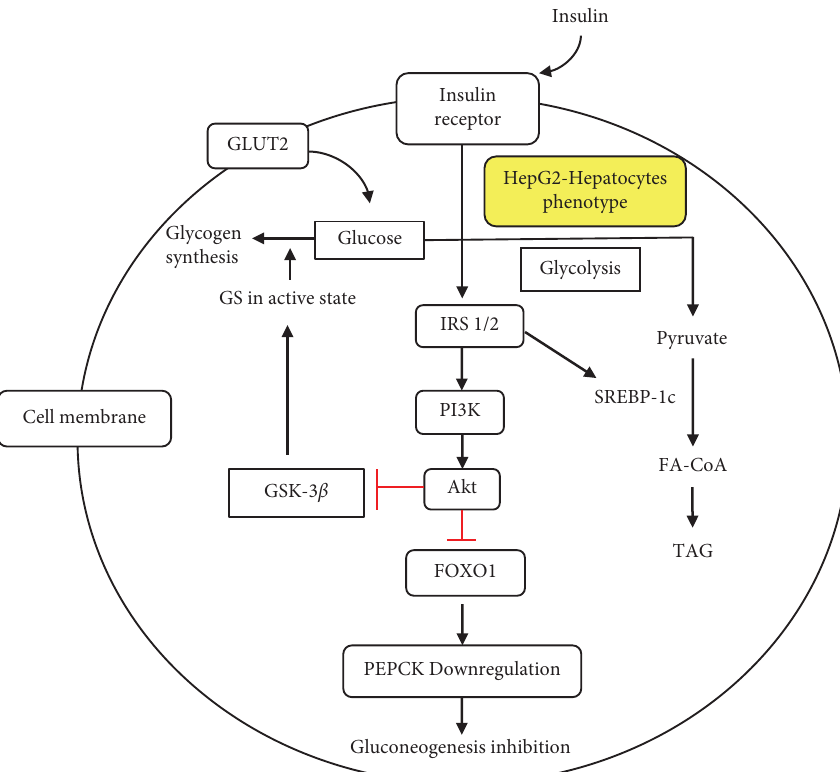
Figure 3: Te insulin signaling pathway in hepatocytes (HepG2 cell lines). Insulin binds to the insulin receptor (IR) and activates the downstream molecules, including IRS1/2, PI3-kinase (PI3K), and Akt. Te activated Akt will inhibit GSK-3 β and allow glycogen synthase (GS) to be in an active state to facilitate glycogen synthesis. It also suppresses the transcriptional activity of FOXO1, which will downregulate PEPCK and reduce hepatic glucose production. Insulin enhances de novo lipogenesis via sterol regulatory element binding protein 1c (SREBP-1c) to produce triacylglycerol